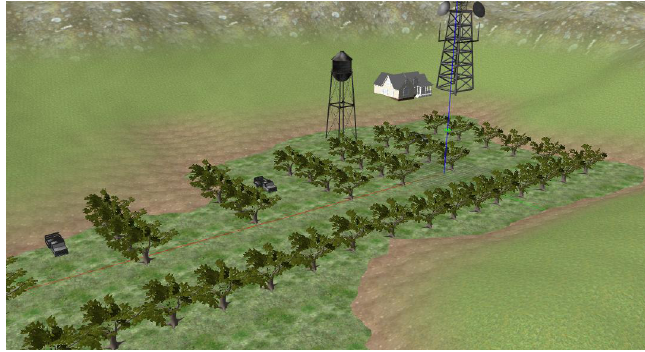
Figure 6. Olive-growing environment simulation.